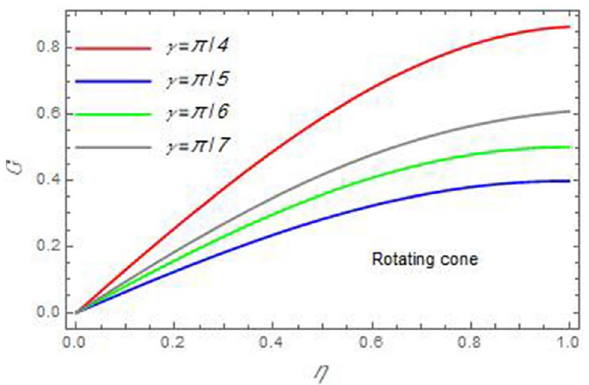
Figure 10. The azimuthal velocity G is plotted versus the axial variable η in the case of stationary disc to depict the effect of the angle between the disc and cone γ .